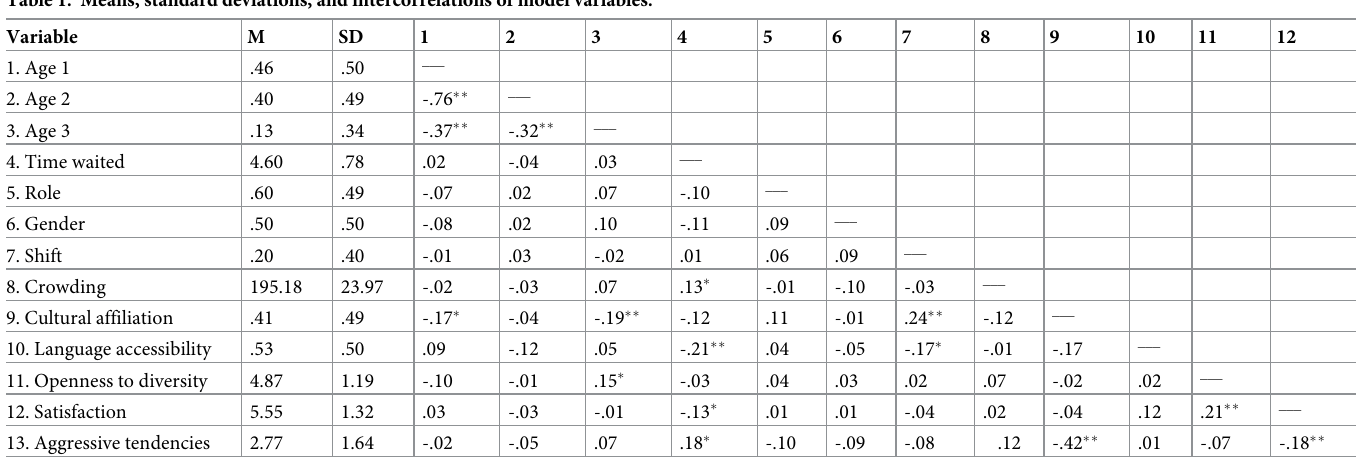
Table 1. Means, standard deviations, and intercorrelations of model variables. Variable